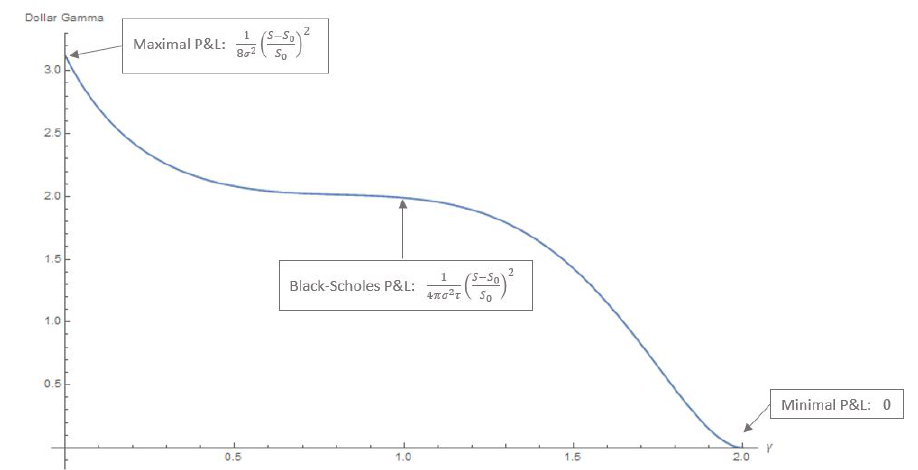
Figure 2. The dollar Gamma for the time-fractional diffusion model ( α = 2, γ ∈ ( 0,2 ] ) maximizes the P&L when γ → 0 and offsets the impact of maturity τ at extremal values ( γ = 0, γ = 2). The graph of the Dollar Gamma possesses an inflection point at the point γ = 1 (the Black-Scholes model). To produce the figure, the following values of parameters were used: σ = 20%, τ = 1 Y